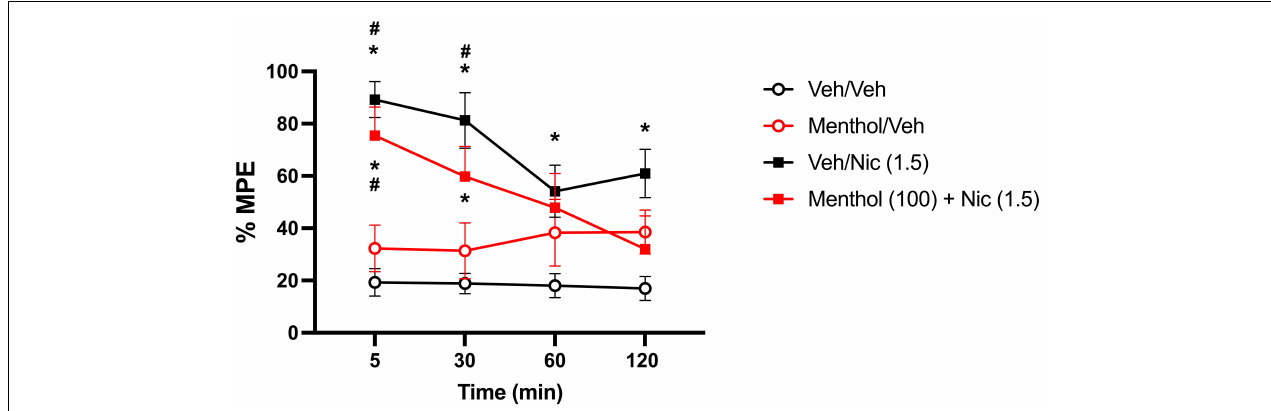
FIGURE 7 | Effects of menthol on nicotine’s effects in the hot plate test in DBA/2J mice. Adult male and female D2J mice were pretreated for 30 min with either menthol (100 mg/kg, i.p.) or vehicle (1:1:18), then received nicotine (1.5, s.c.) or vehicle (saline) and were tested at 5-, 30-, 60- and 120-min post-injection. Antinociceptive response was calculated as percent maximum possible effect (% MPE). Data are expressed as the mean ± SEM of 10 mice/group. Results are based on a RM two-way ANOVA with time and treatment as factors. * P < 0.05 compared with veh/veh group. # P < 0.05 compared with menthol/veh group. veh, vehicle; nic,